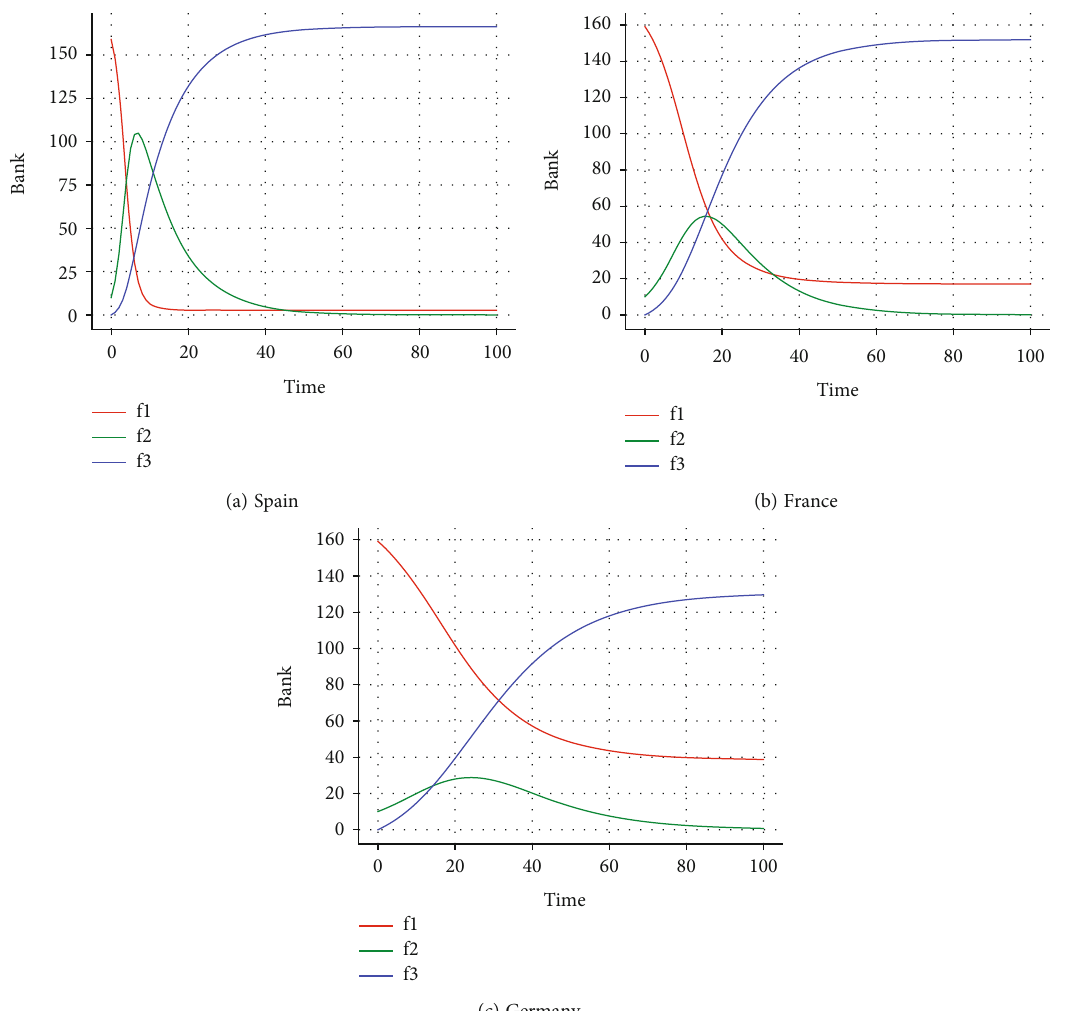
= 0 : 1 and t = 100 3